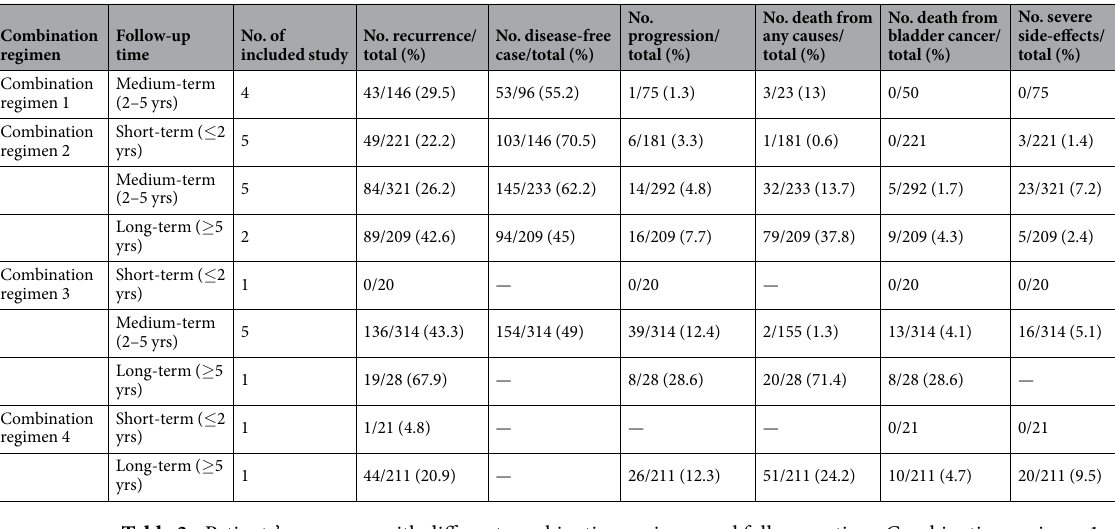
Table 3. Patients’ prognoses with different combination regimen and follow-up time. Combination regimen 1: a single dose of perioperative MMC prior to BCG; Combination regimen 2: sequential instillation with MMC